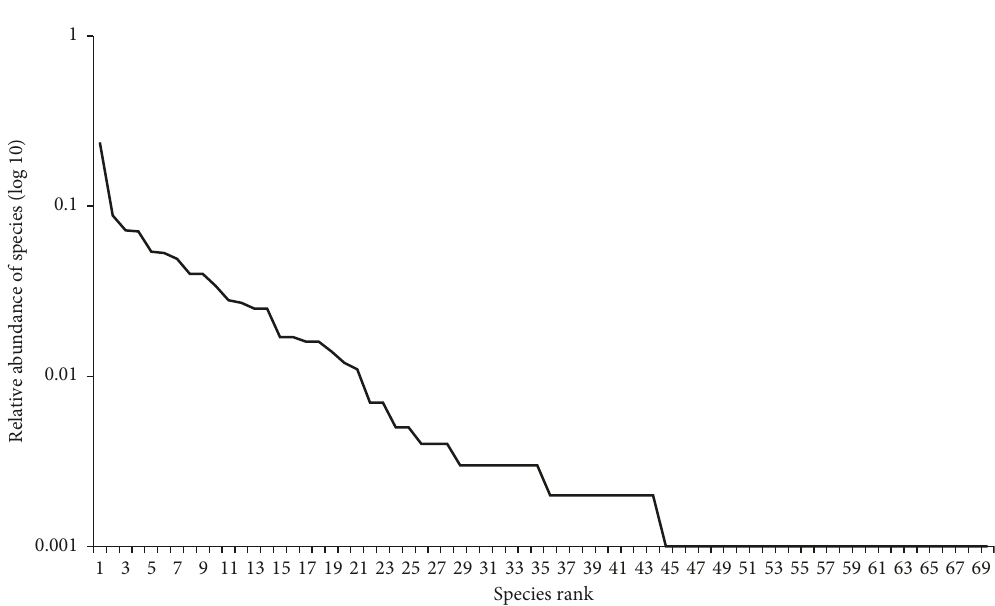
Figure 3: Rank-abundance curve for bee species between August 2013 and December 2014 in Carutapera, MA.